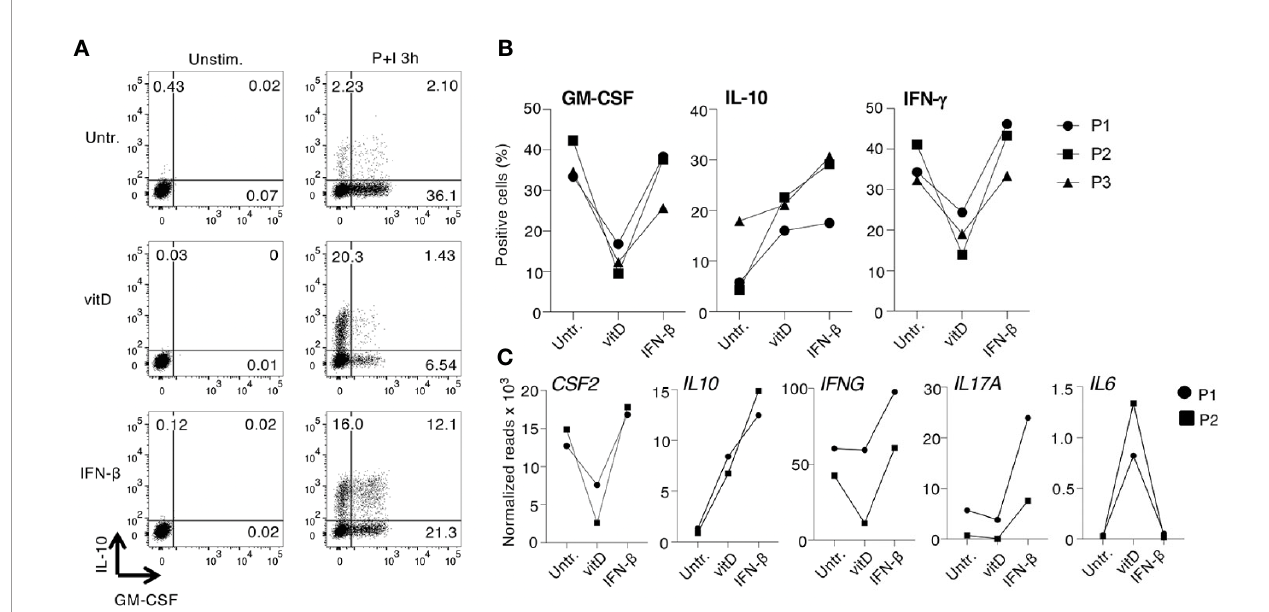
FIGURE 5 | Expression of cytokines and immune transcripts in CD4 + T cells from multiple sclerosis (MS) patients. (A) Memory CD4 + T lymphocytes were freshly separated from the peripheral blood of one patient with MS at relapse, activated with plate-bound anti-CD3 and anti-CD28 antibodies and cultured for 5 days with vitamin D or IFN- b . Expression of IL-10 and GM-CSF was determined by intracellular staining. Representative of n=3 independent donors. (B) Cells from three independent MS patients were treated as in (A) and the percentages of GM-CSF, IL-10, and IFN- g -producing cells was determined by intracellular staining (n=3). (C) Memory T cells obtained from two patients with MS were treated as in (A) , except that total RNA was extracted and the expression of ~570 immune-related genes was measured by Nanostring pro fi ling. Results for selected transcripts are shown. The entire list of genes (including also data from naïve T cells from the same patients) can be found in Supplementary Data Set 1